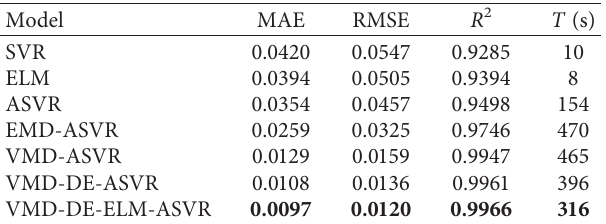
Table 5: The comparison result of different model performances for data set